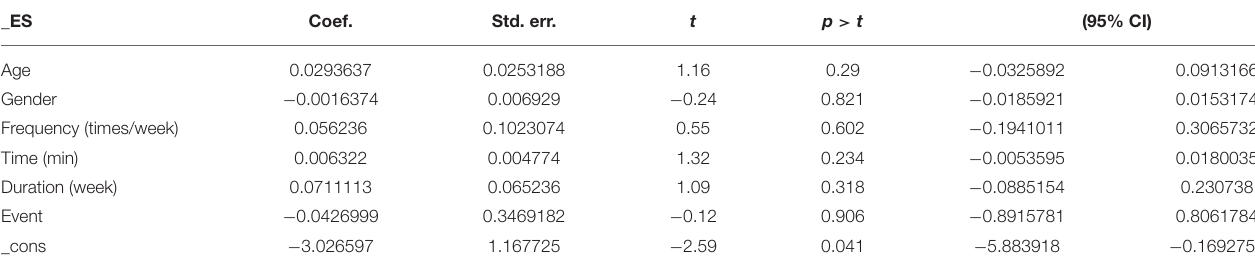
TABLE 3 | Covariate regression analysis of PTSD symptoms in patients with PTSD.